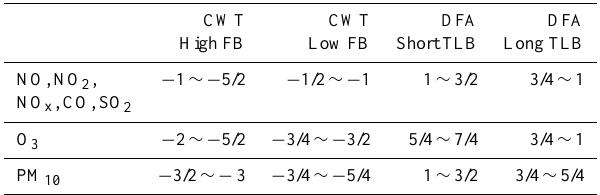
Table 1. The ranges of CWT and DFA exponents for chemical gases and aerosol data measured at the 74 air quality monitoring